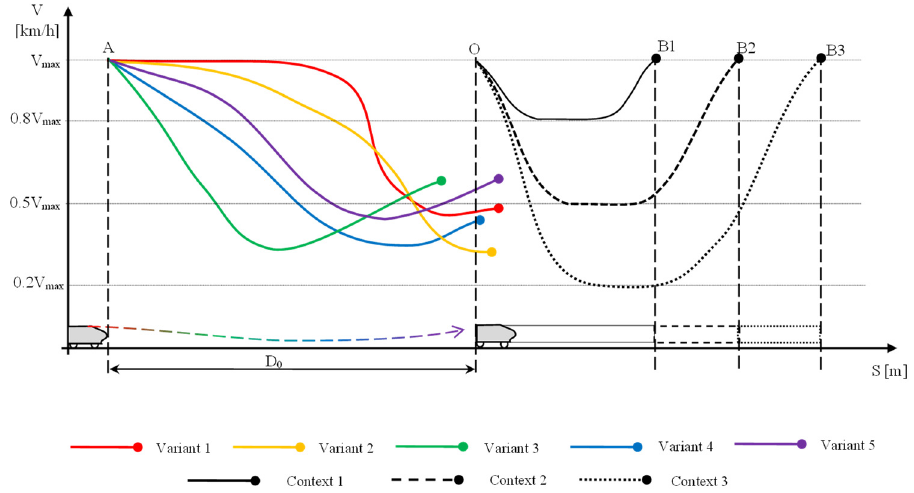
Figure 1. An overview diagram of the traffic model (source: own development).